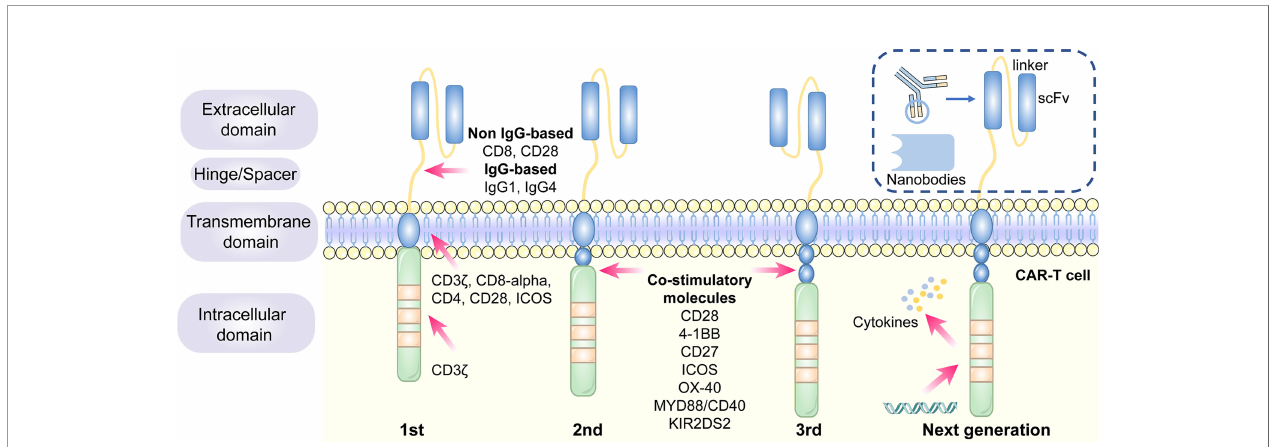
FIGURE 2 | The structure and evolution of CAR-T cells from the fi rst generation to the fourth generation. The CAR-T cells are consisted of extracellular tumor antigen binding domains (scFv, nanobodies), hinge regions, transmembrane regions and intracellular signaling domains. Different generations of CAR structures are primarily characterized by distinct intracellular signaling domains. The fi rst generation of CAR-T cells only contain a CD3 z intracellular signaling domain, with less persistence and ef fi cacy in clinical practice. The second or third generation of CAR-T cells include one or more costimulatory molecules, and the next generation of CAR-T cells are engineered to express cytokines, which greatly improve their competence to eliminate the tumor